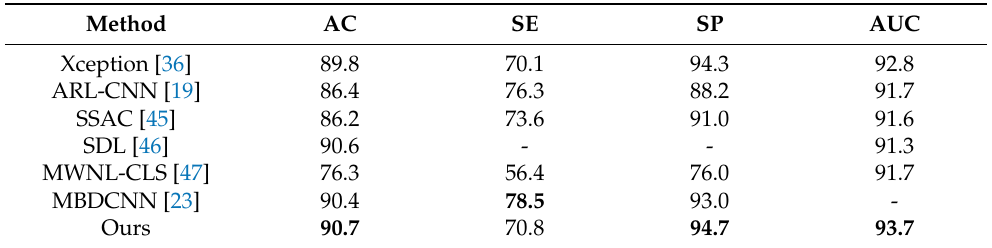
Table 4. Comparison of the average classification performance between CL-DCNN model and other skin lesion classification methods on the ISIC 2017 testing set. The highest results are shown in bold font for easy observation and analysis.